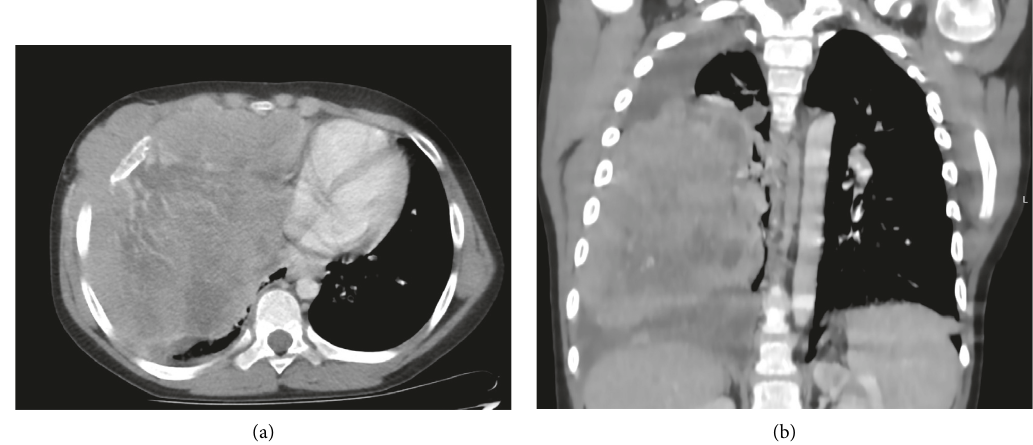
Figure 1: (a, b) A CT chest performed at the initial encounter. The CT chest obtained at the initial encounter revealed a large, het- erogeneously enhancing mass occupying the majority of the right hemithorax with peripheral